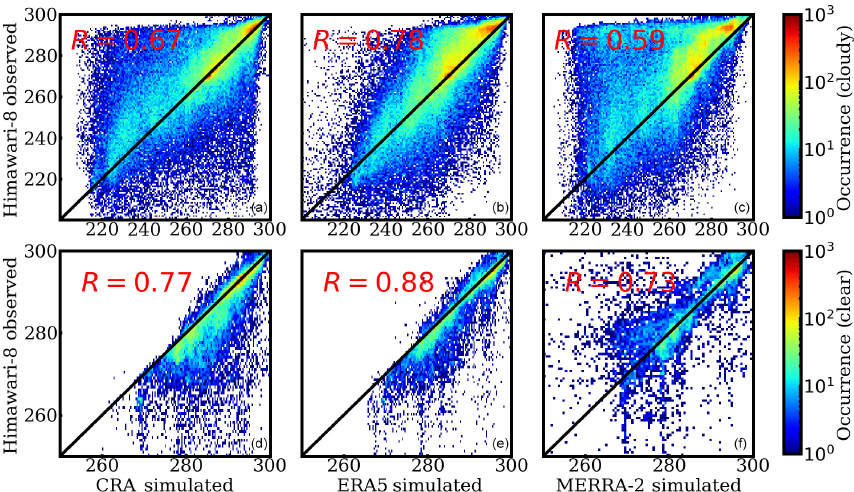
Figure 5. Comparisons between the observed and simulated BTs in the 11.2µm channel for cloudy (a, b, c) and clear-sky (d, e, f) pixels, respectively.